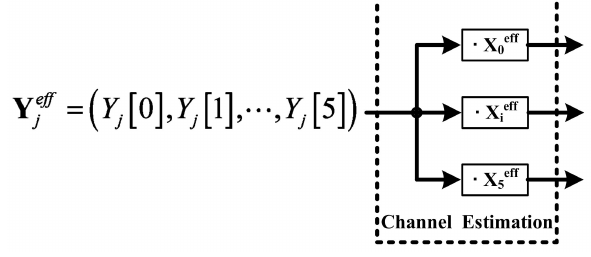
Figure 9. The concept of the channel estimation.